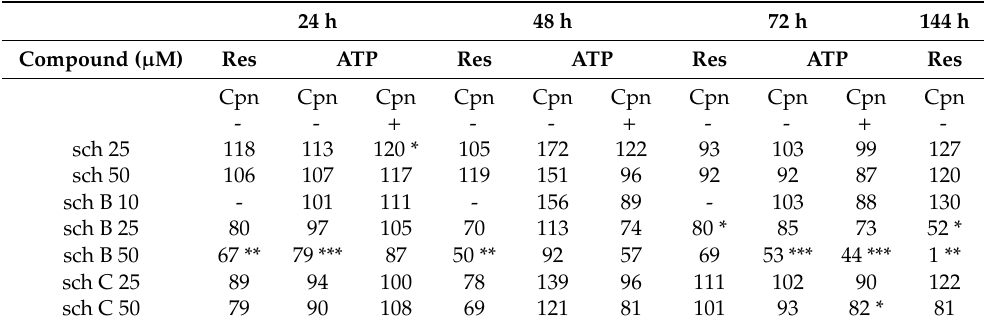
Table 1. Impact of dibenzocyclooctadiene lignans on THP-1 macrophage cell viability with (Cpn +) and without (Cpn -) C. pneumoniae infection.